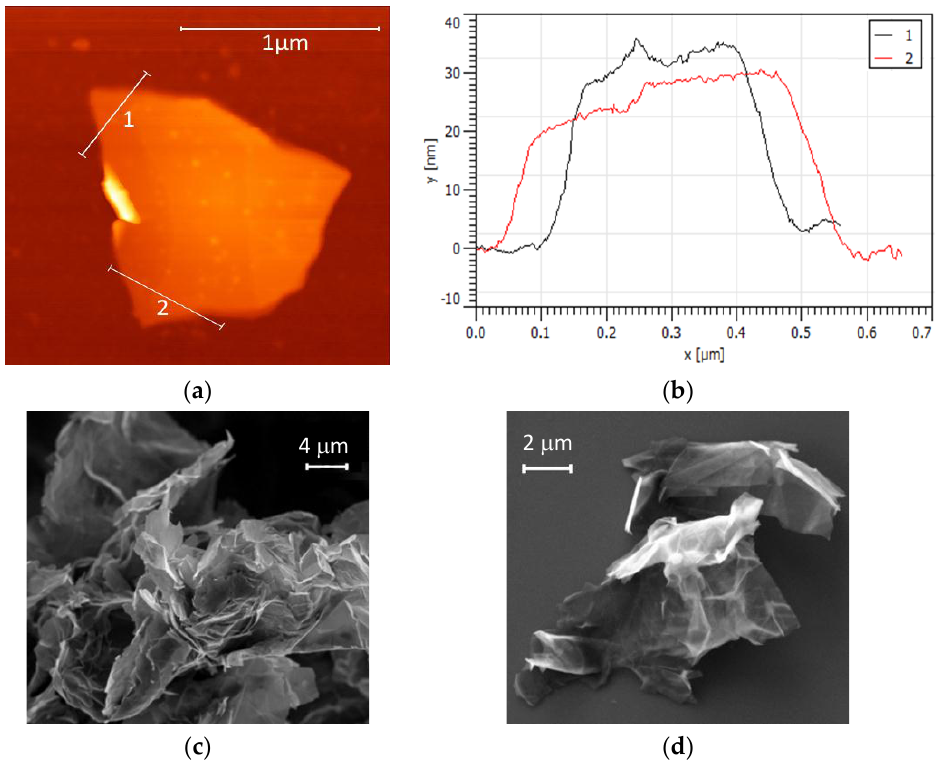
Figure 1. ( a ) AFM image of graphene nanoplatelets (GNPs) and ( b ) corresponding thickness profiles. ( c , d ) field emission-scanning electron microscope (FE-SEM) images of GNP powders at different magnifications.